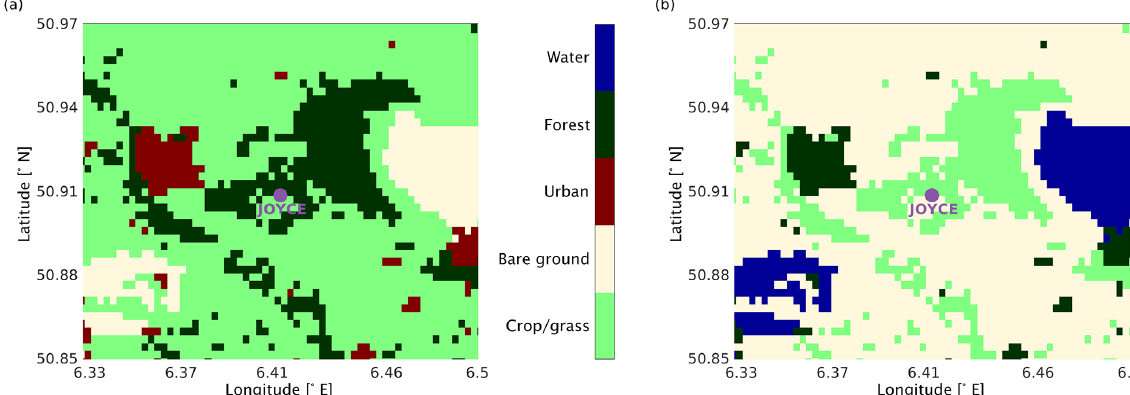
Figure 5. (a) A 12km × 13km map of the simplified GlobCover land use data centered around JOYCE used for the first ICON-LEM simu- lation (ICON1). (b) Same as panel (a) but with altered land use types for the second simulation (ICON2).